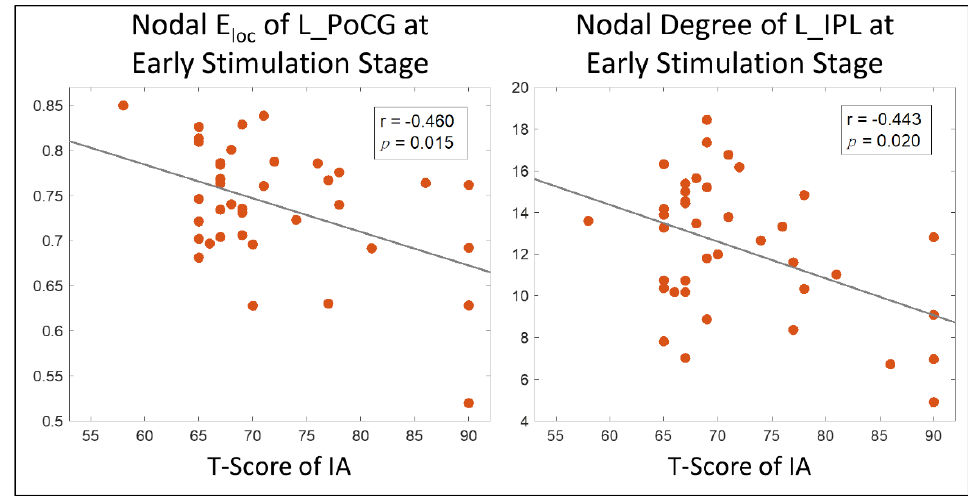
Figure 4. Brain-behavior correlation analysis results. E loc : local efficiency; L_PoCG: left postcentral gyrus; IA: inattention; L_IPL: left inferior parietal lobule.